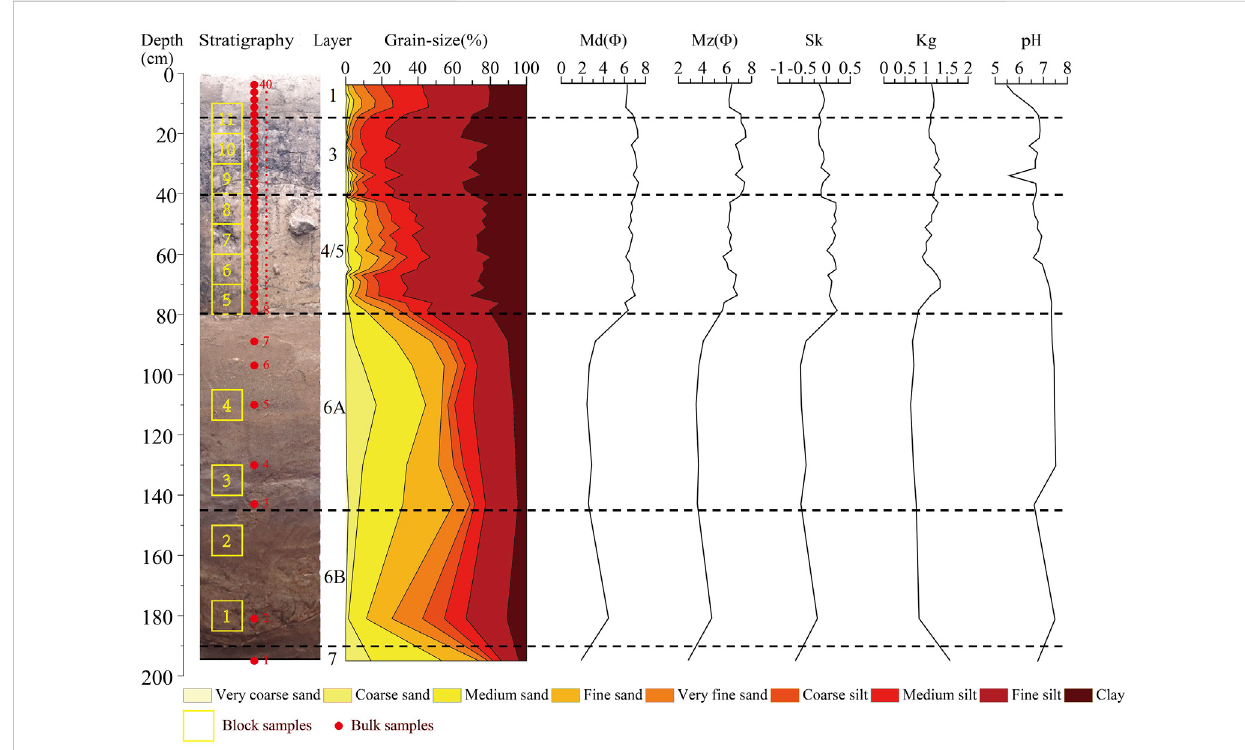
FIGURE 3 Stratigraphy of the Dadong Site and the soil sampling positions (left); analytical results of particle size analysis and pH measurement